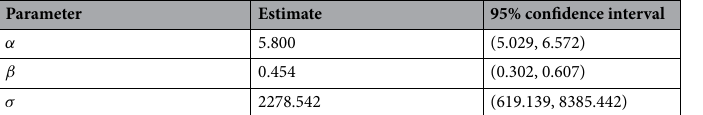
Table 2. Maximum likelihood estimates for the models for IgM S1-RBD, after excluding days post-onset of symptom variable.